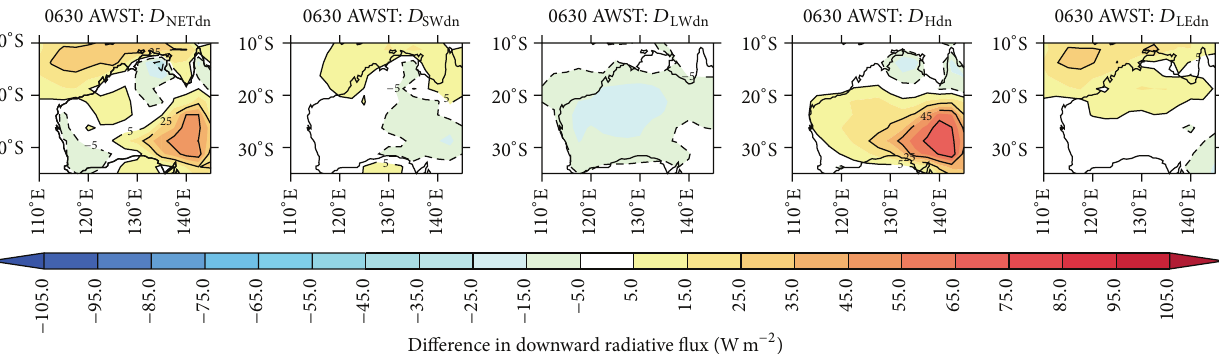
Figure 9: The difference between A1.1 and A1.0 climatological (1979–2001) mean 3-hourly downward radiative fluxes (Wm −2 ) at the surface. Column 1: net radiative flux ( 𝐷 NETdn ); column 2: short-wave radiative flux ( 𝐷 SWdn ); column 3: long-wave radiative flux ( 𝐷 LWdn ); column 4: sensible heat flux ( 𝐷 Hdn ); column 5: latent heat flux ( 𝐷 LEdn ). Time averages are centred on (from row 1 to row 8) 0930 AWST, 1230AWST,